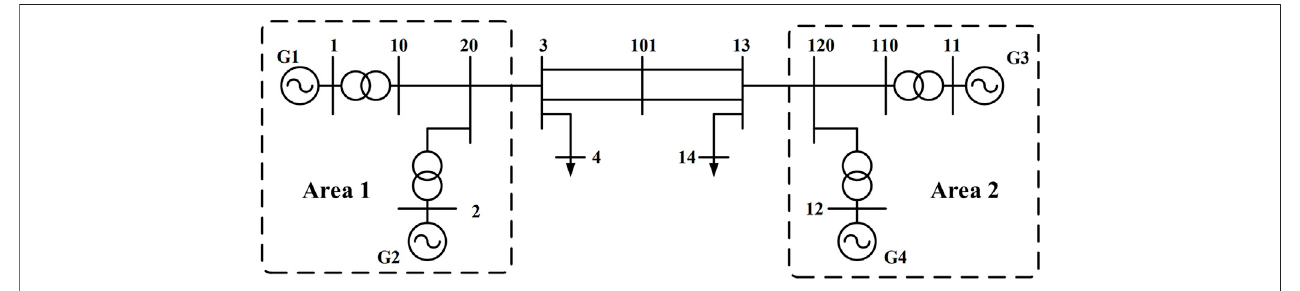
FIGURE 3 | Single-line diagram for the 4-generator 2-area power system.